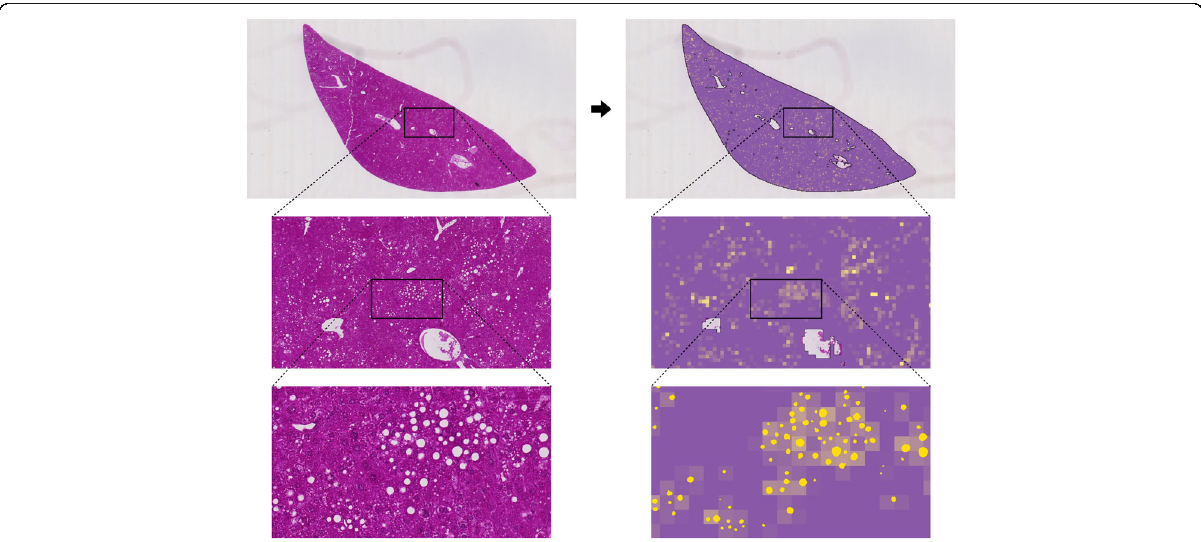
Fig. 3 Tile-based steatosis quantification. The steatosis area fractions of tiles are visualized as colors from purple to yellow. At highest magnification, the identified fat droplets are masked in